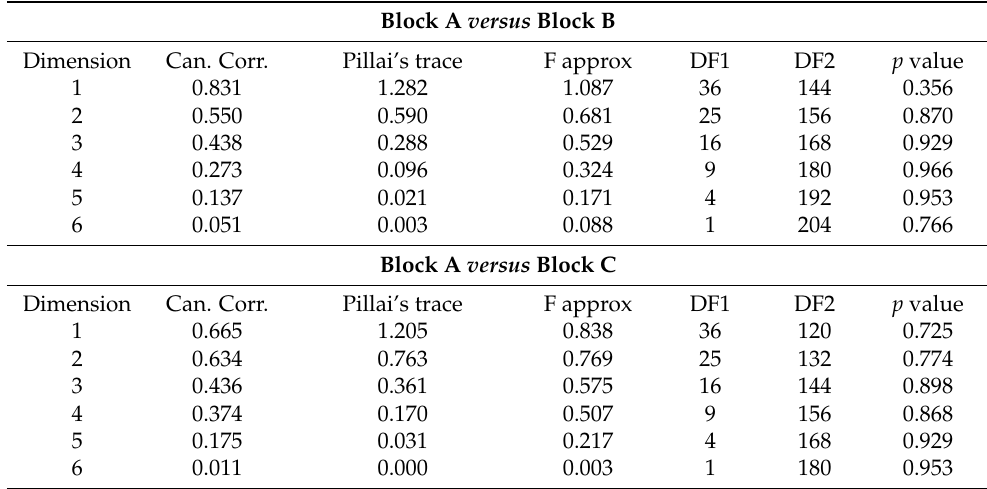
Table 4. Results of the Canonical Correlation Analysis when Comparing by Pairs the Blocks of Measurements Performed in the Down syndrome